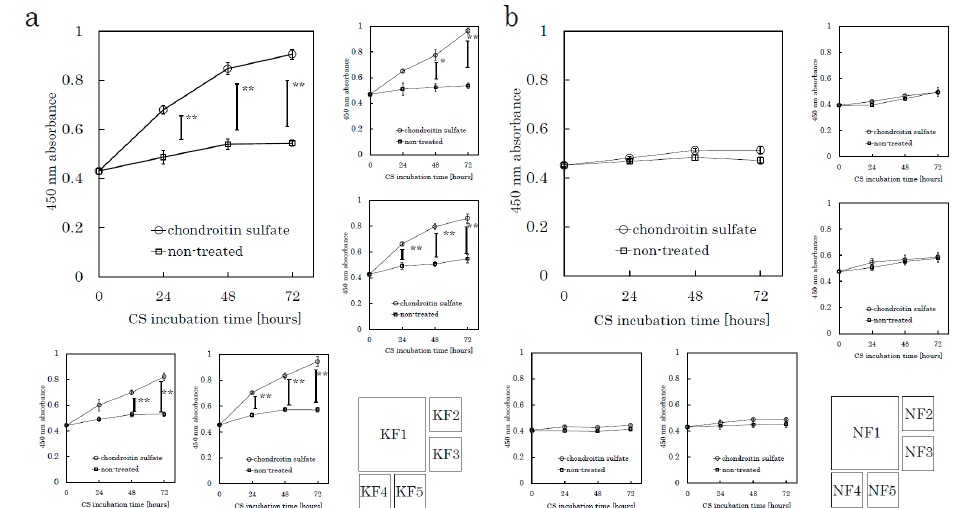
Figure 1. CS stimulates keloid fibroblast (KF) proliferation but not normal fibroblast (NF) proliferation. KFs and NFs were cultured with chondroitin sulfate (CS) or without CS. Cell proliferation was analyzed using a colorimetric assay with a water-soluble tetrazolium salt as the substrate. Proliferation curves of KFs (K1 to K5, Table 1) ( a ) and NFs (N1 to N5, Table 1) ( b ) are shown. Error bars represent the standard deviation ( n = 3). * p < 0.05, ** p < 0.01.